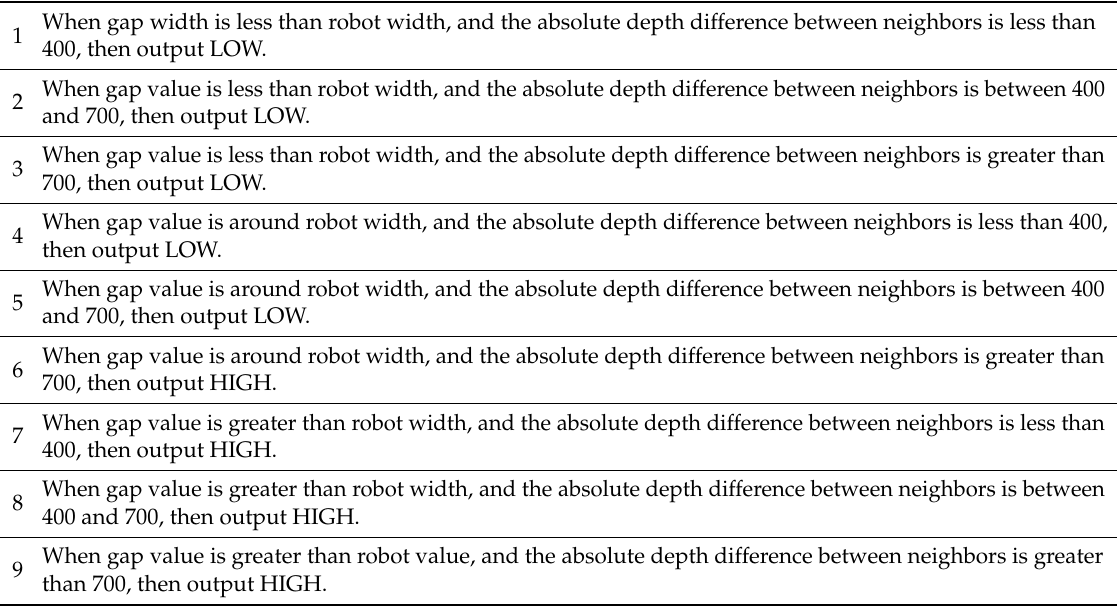
Table 2. Fuzzy rules for using depth map alone.